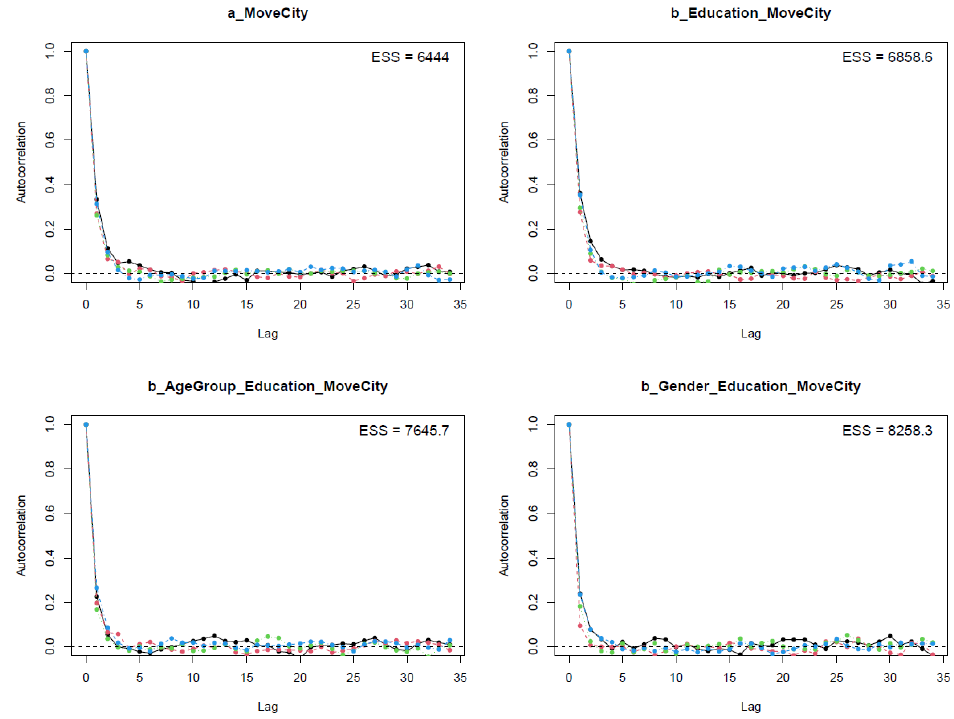
Figure 5. Autocorrelation plots for Model 1′s posterior parameters.